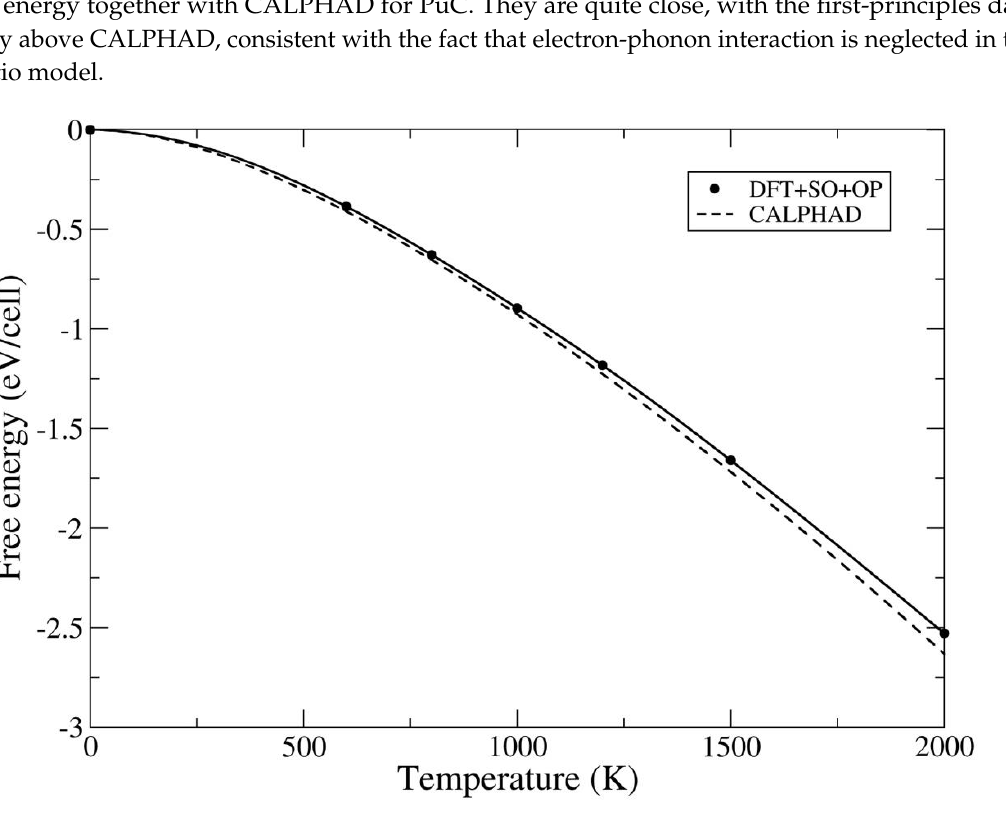
Figure 6. Free energies from our best first-principles theory and CALPHAD (same as in Figure 5). The solid line is guide to the eye only.